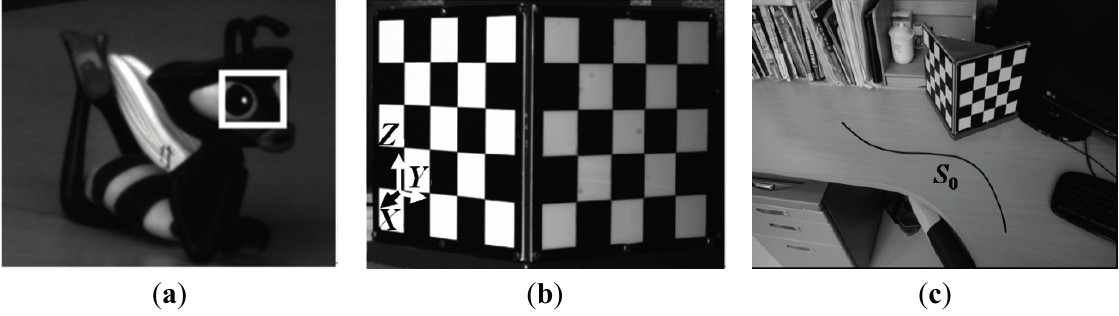
Figure 3. Experimental scene of 2D trajectory. ( a ) An object point; ( b ) A chessboard for the camera calibration and the definition of coordinate system; ( c ) The guiding line S 0 .